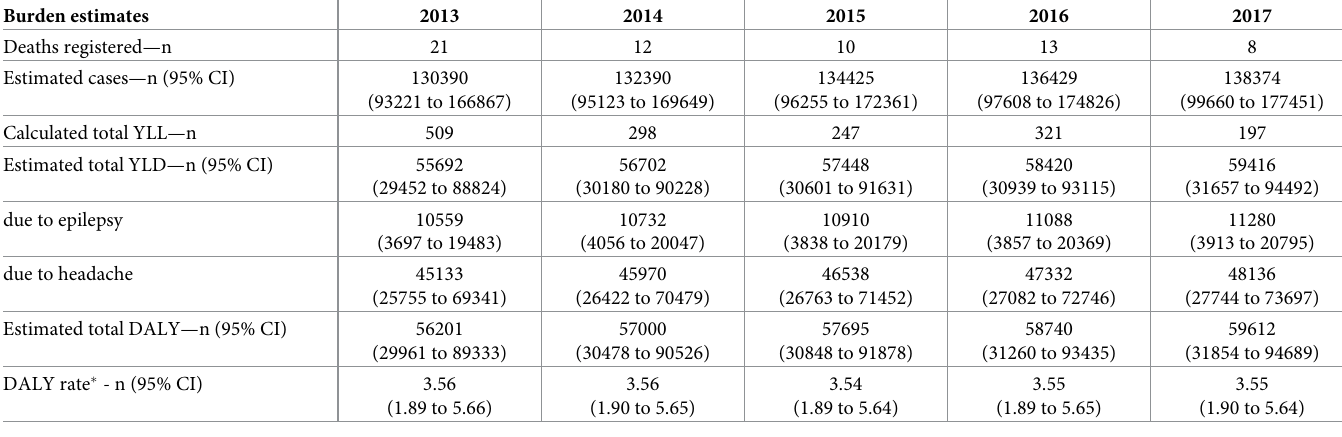
Table 3. Burden of disease estimates due to human neurocysticercosis in Ecuador between years 2013–2017.